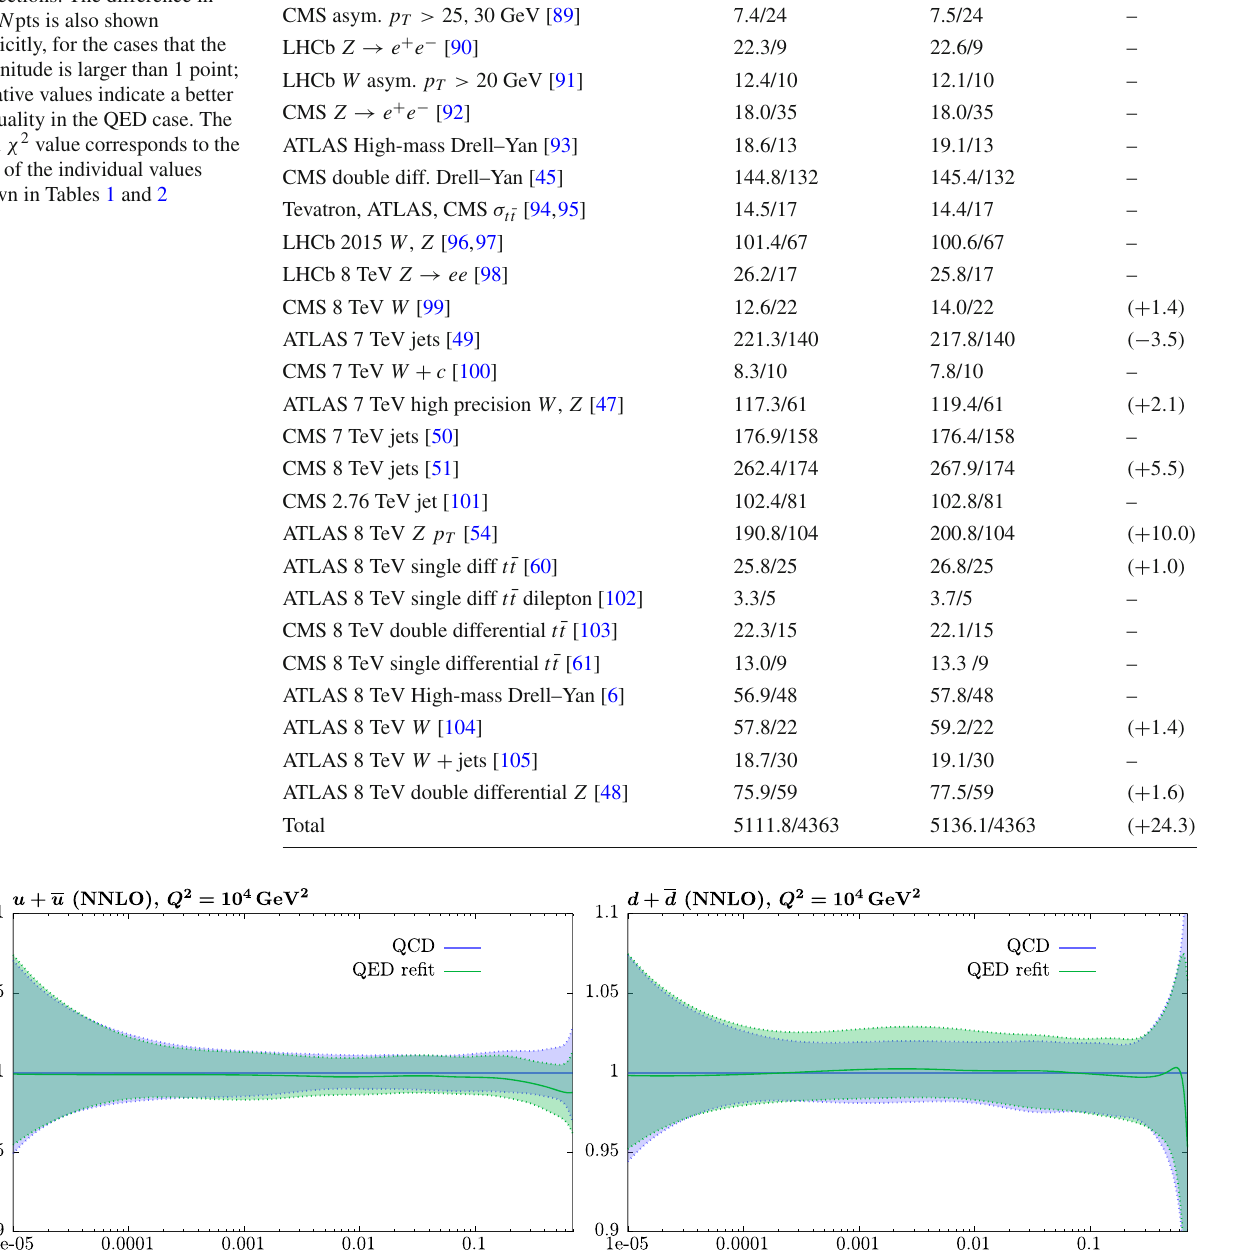
Table 2 The values of χ 2 / N pts for the LHC data sets included in a NNLO fit to the MSHT20 dataset, with and without QED corrections. The difference in χ 2 / N pts is also shown explicitly, for the cases that the magnitude is larger than 1 point; negative values indicate a better fit quality in the QED case. The total χ 2 value corresponds to the sum of the individual values shown in Tables 1 and 2